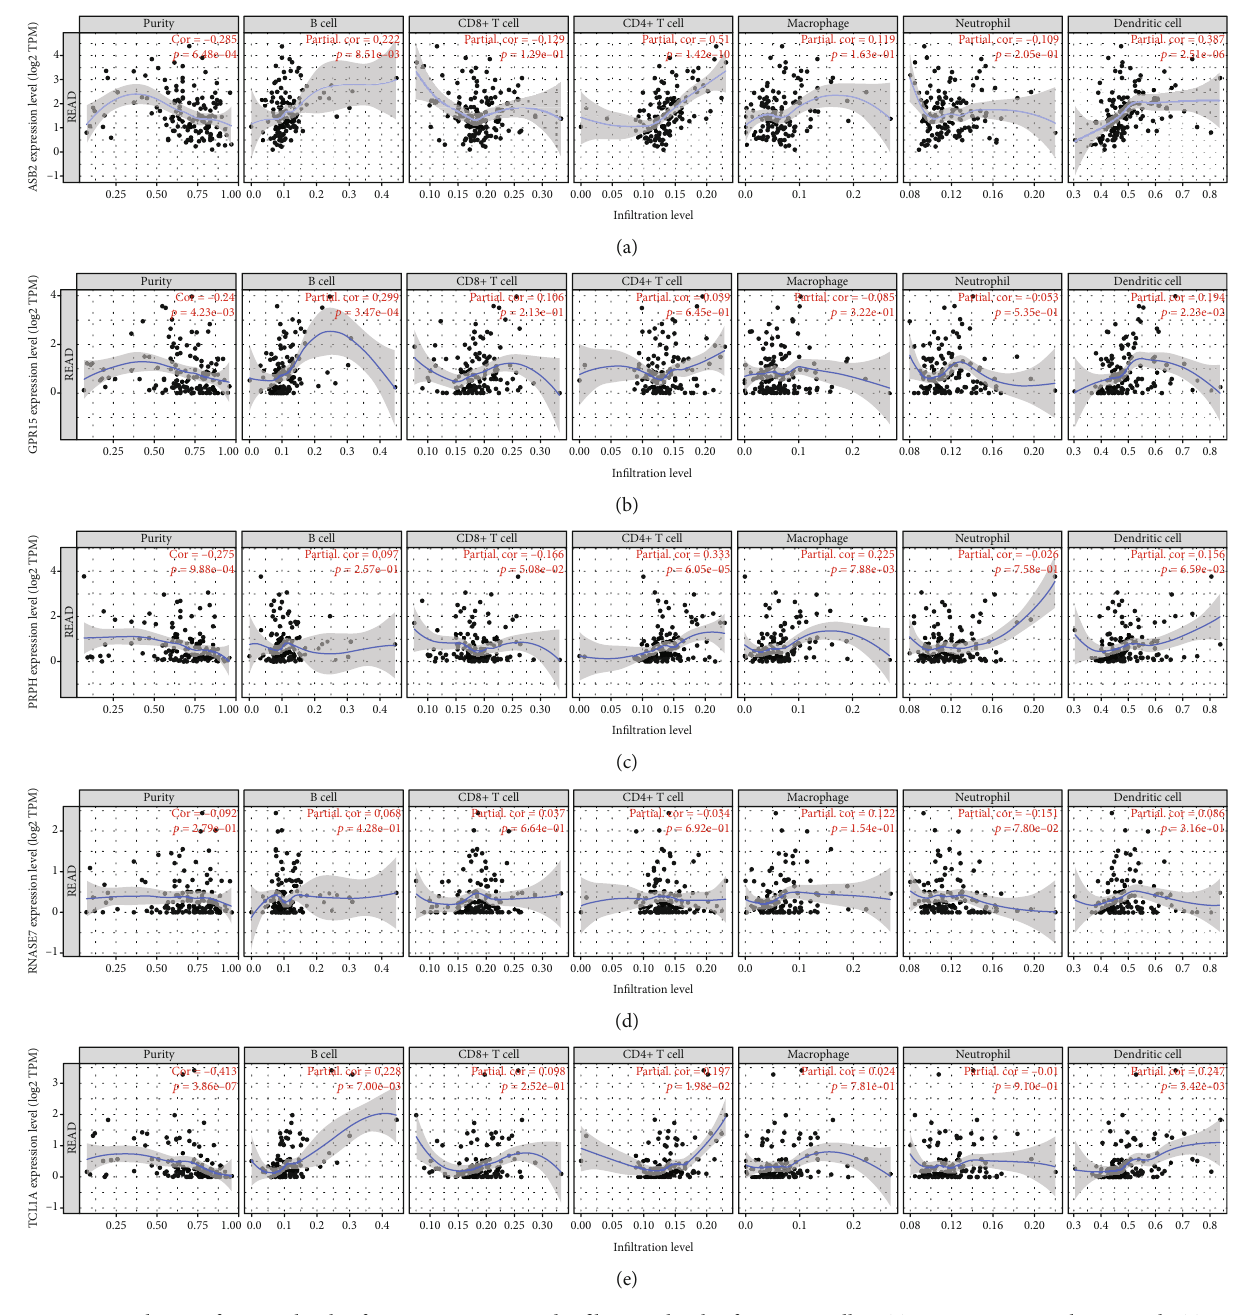
Figure 7: Correlation of mRNA levels of prognostic genes and in fi ltration levels of immune cells in TCGA-READ samples using the TIMER database. (a) ASB2. (b) GPR15. (c) PRPH. (d) RNASE7. (e) TCL1A. TCGA: The Cancer Genome Atlas; READ: rectal adenocarcinoma; TIMER: Tumor Immune Estimation Resource; ASB2: ankyrin repeat and SOCS box containing 2; GPR15: G protein-coupled receptor 15; PRPH: peripherin; RNASE7: ribonuclease A family member 7; TCL1A: TCL1 family AKT coactivator